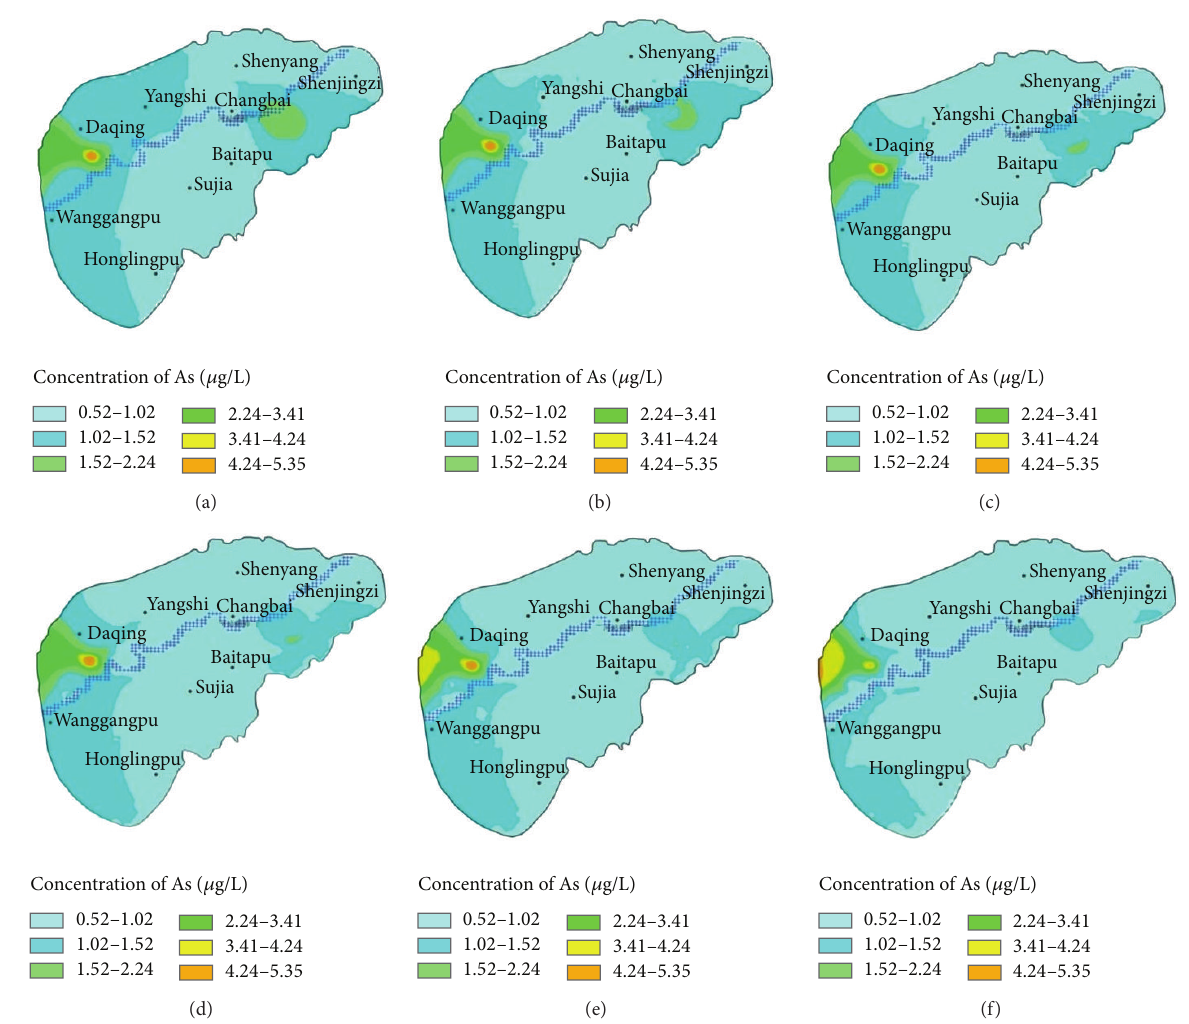
Figure 5: Diffusion and transport of As in shallow aquifer. (a) Distribution of initial content; (b) after 1 year; (c) after 2 years; (d) after 3 years; (e) after 5 years; (f) after 10 years. Table 3: Distribution area of As at different concentration ranges in different years with addition of a pollution source. Distribution area (km 2 Time (year)